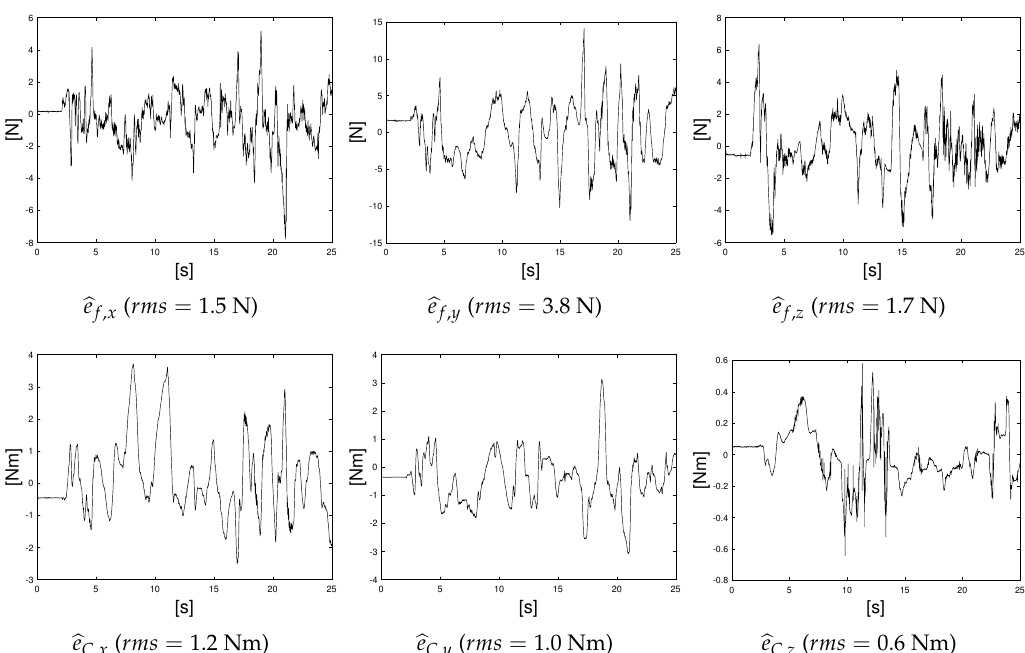
Figure 10. Estimated interaction forces (cid:98) e f and torques (cid:98) e C errors for the #1 experimental scenario.